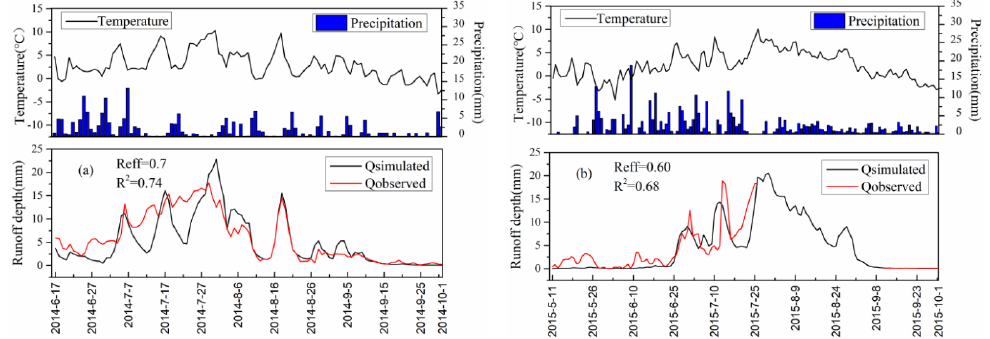
Figure 7. Observed precipitation, temperature, and runoff depth and simulated runoff depth (validation period from 2014 ( a ) to 2015 ( b )).